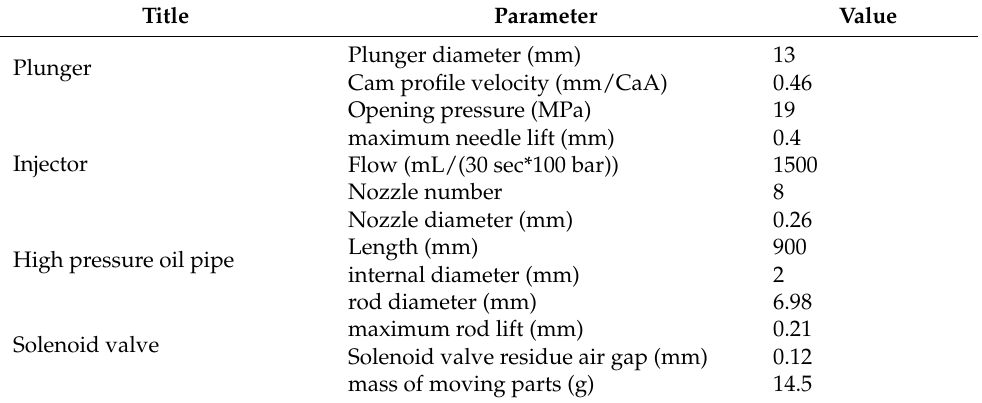
Table 2. Main parameters of the fuel injection system (FIS) of the electronic control unit (ECU)